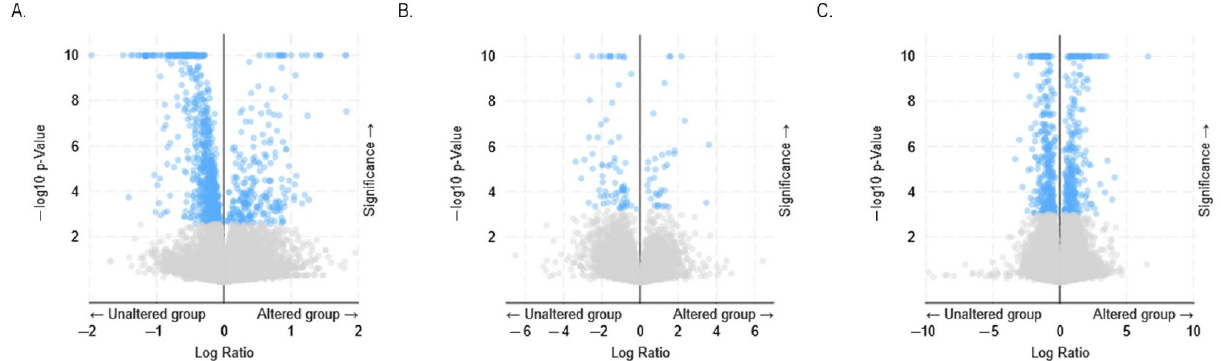
Figure 2. HUNK alterations on cancer signaling. ( A ) Using the data from CPTAC (Clinical Proteomic Tumor Analysis Consortium) in cBioPortal, 122 breast tumors from TCGA (The Cancer Genome Atlas) were examined for significant changes of mRNA, shown as a volcano plot. ( B ) Volcano plot showing significant changes in protein. ( C ) Volcano plot showing the significant changes in phosphorylated proteins.